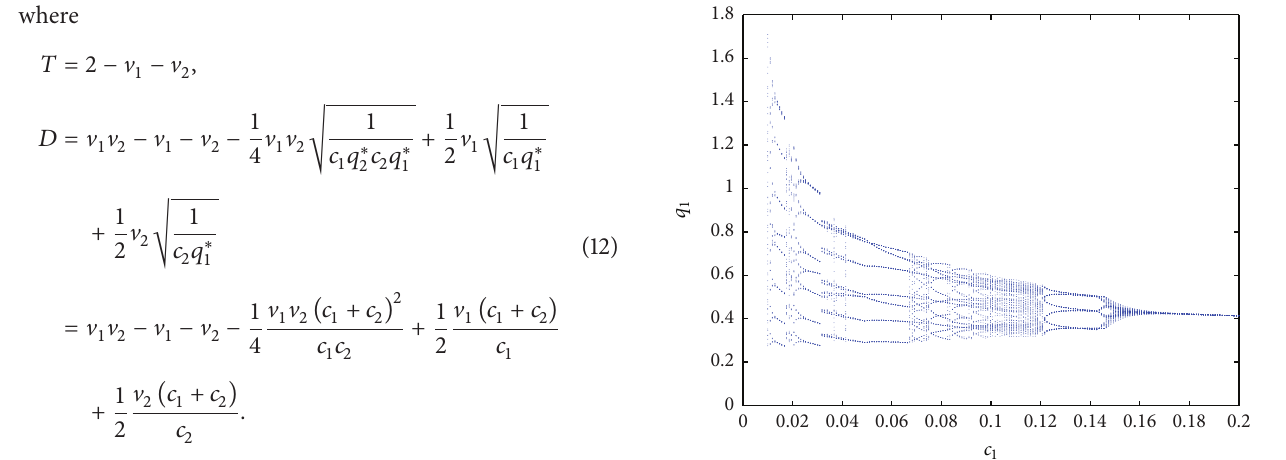
Figure 1: Bifurcation diagram with respect to parameter 𝑐 1 against variable 𝑞 1 with 500 iterations of map (8) for V 1 = V 2 = 0.5 , 𝑐 2 = 2